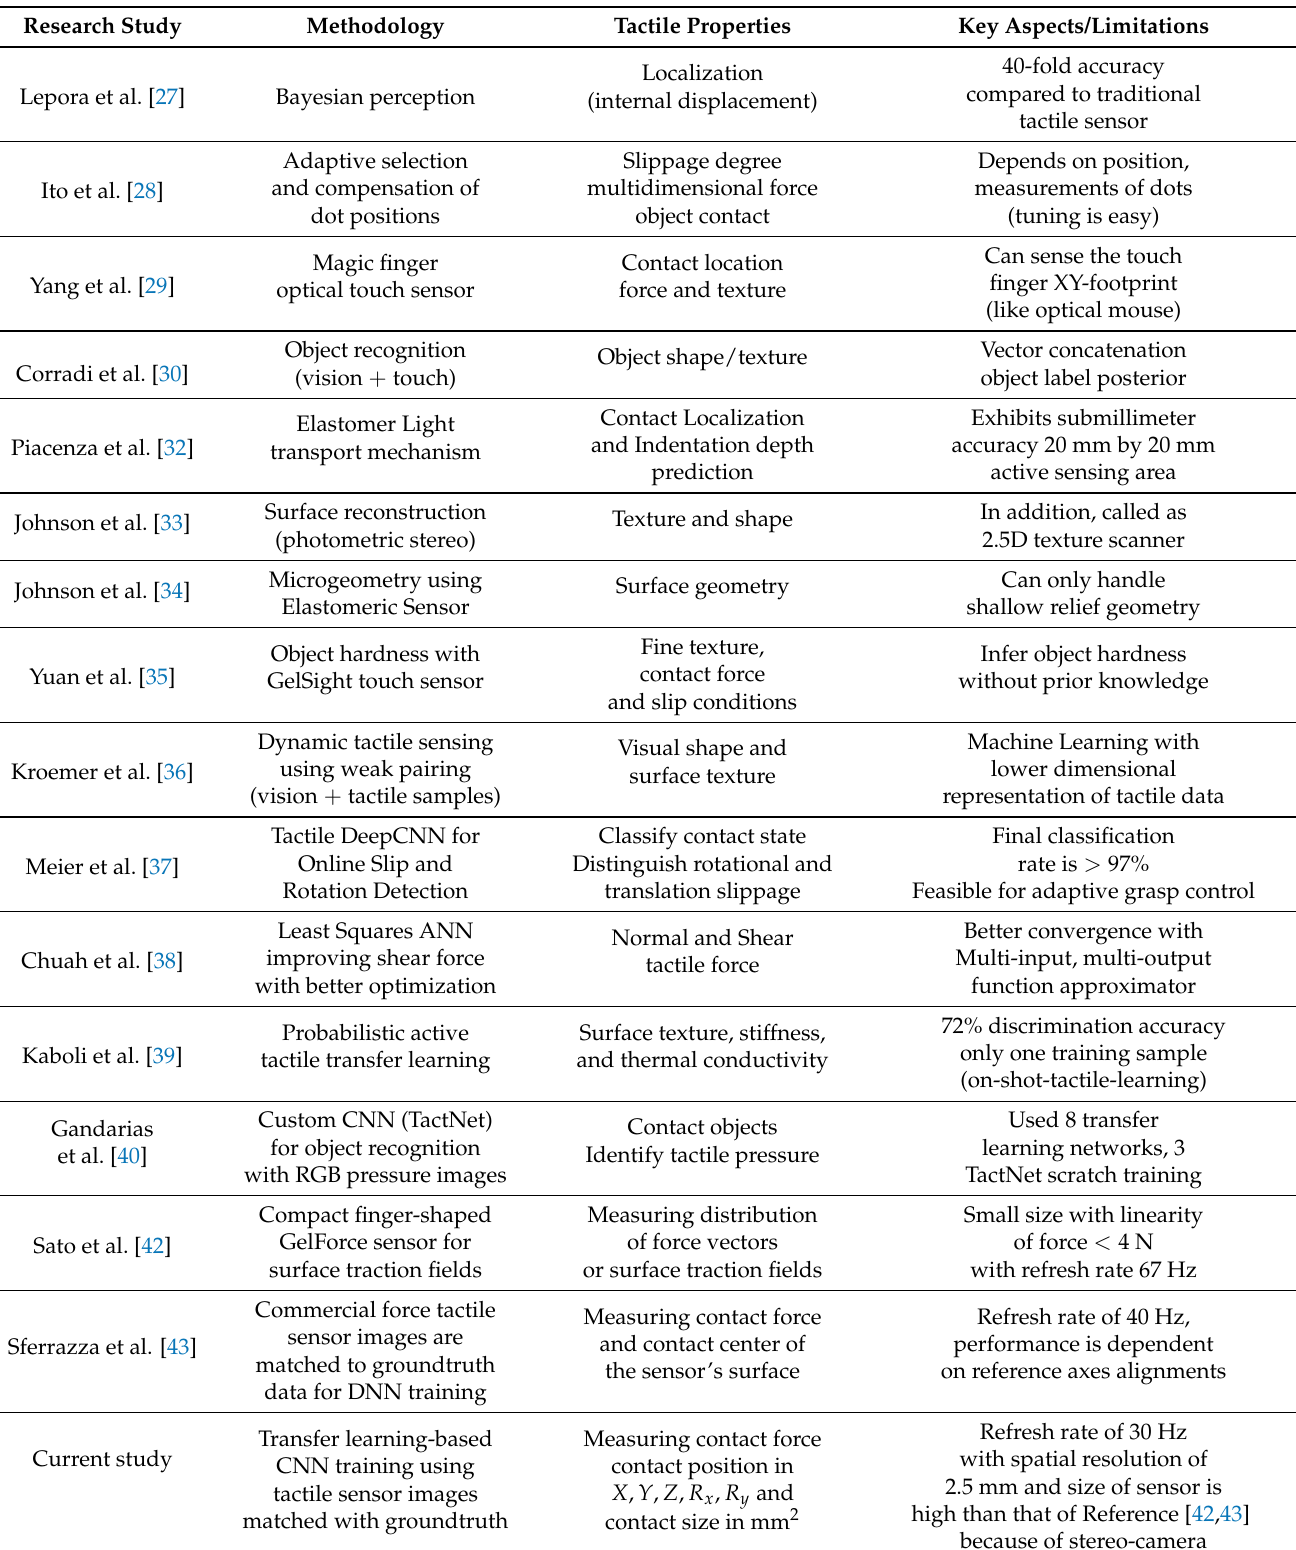
Table 1. Insights of traditional and learning-based visual tactile sensing